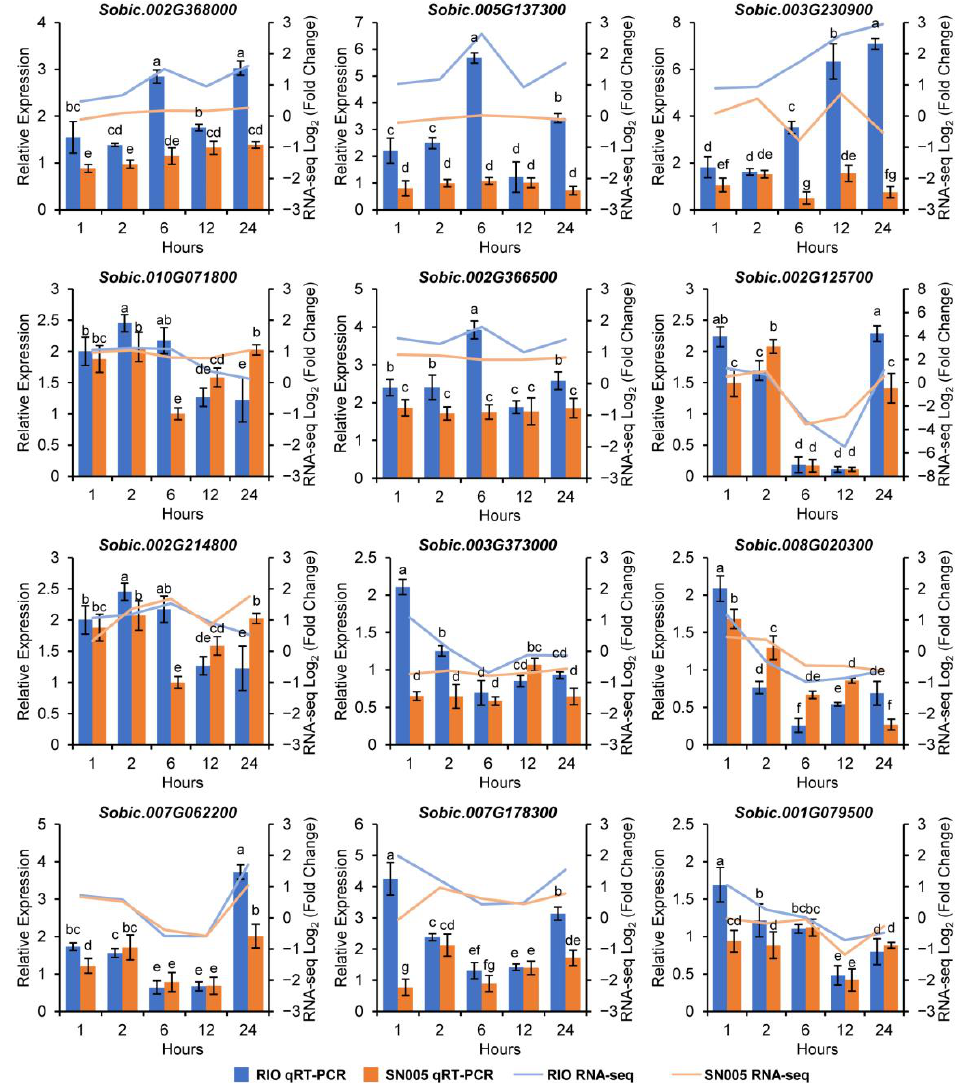
Figure 6. Quantitative RT-PCR validation of 12 DEGs. Three biological replicates of each sample were used for qRT-PCR analysis. Expression of DEGs was normalised to the endogenous control SbPP2A gene (ΔCT gene = CT gene − CT SbPP2A ). The ΔΔCT of each biological replicate was calculated by the difference of ΔCT between each replicate and the mean ΔCT of CKs . The relative expression level was calculated by 2 −ΔΔCT . Error bars represent the standard deviation of relative expression level from three biological replicates. Bars with different lowercase letters are significantly different at p < 0.05 (Duncan’s multiple range test). The lines show the Log 2 fold change expression of the DEGs from RNA-seq